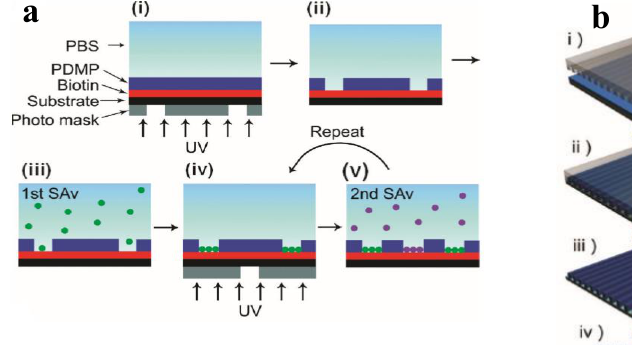
Figure 3. Chemical structure of Photoresist (PR) ( a ) spin-coated on Poly(allylamine) hydrochloride(PAH) and its mechanism for in situ polyelectrolyte bilayer formation (Reprinted with the permission from reference [79] Copyright 2004 American Chemical Society).